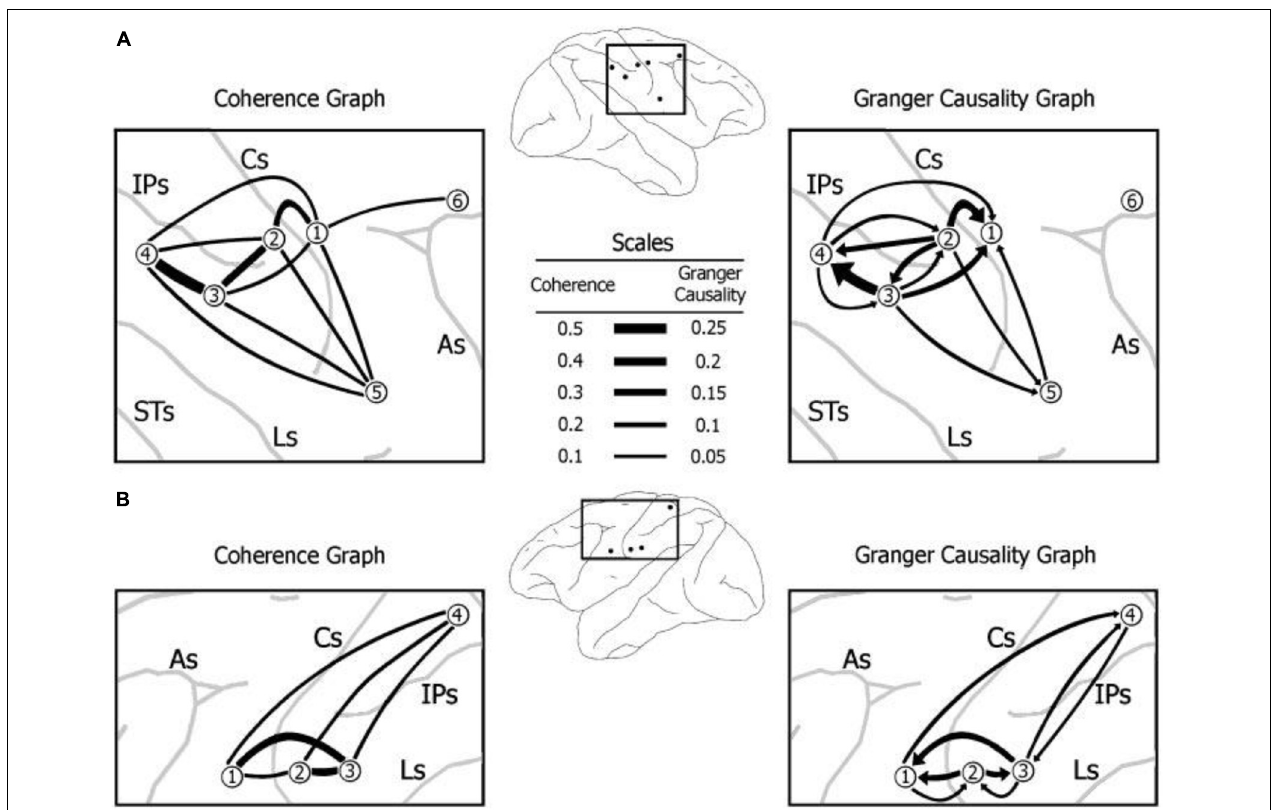
FIGURE 1 | Prestimulus beta-frequency coherence and (conditional spectral) Granger causality maps derived from the sensorimotor cortices of two monkeys (A,B) . A self-generated hand press (–1250 to –500 msec) cued the monkey that a visual stimulus (0 msec onset; 100 msec duration) was soon to appear on a visual display screen. The stimulus was subsequently perceptually discriminated as part of a visual pattern discrimination task (water reward given on response trials 500 msec after stimulus onset) (Bressler et al., 1993). In each case, the pattern of synchronization (coherence) and Granger causality of beta-band oscillations from primary and secondary somatosensory and motor cortices consistent with execution of the hand press cue: somatosensory input is fed to the primary somatosensory cortex and motor output is transmitted from the primary motor cortex to the motor spinal cord to the hand muscles to execute the hand press.